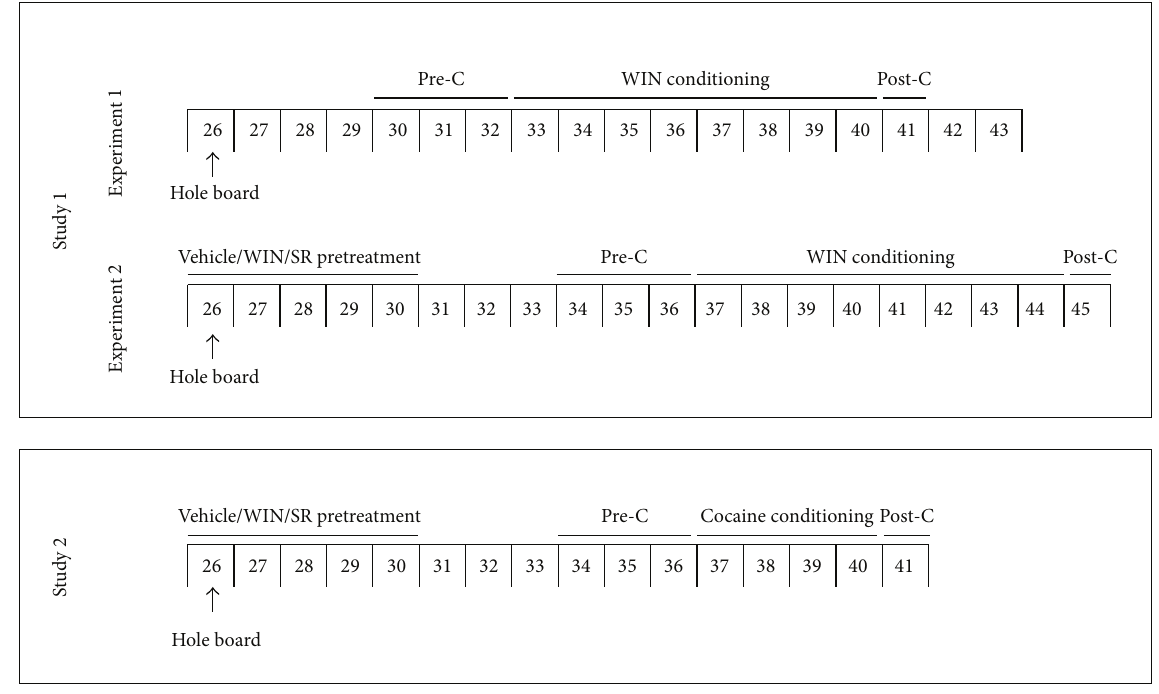
Figure 1: Timeline of